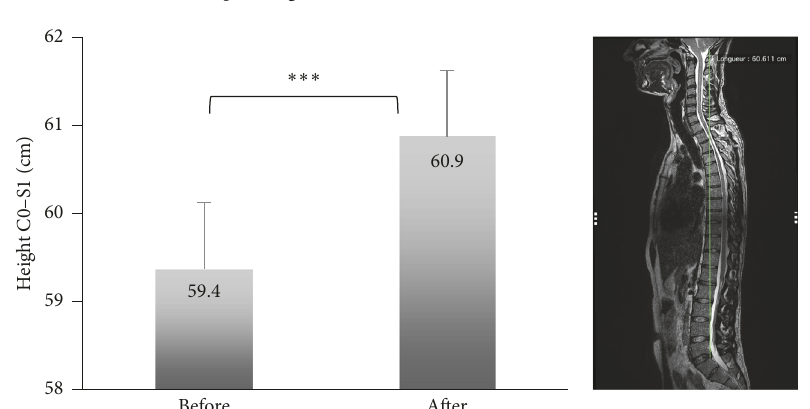
Figure 3: Comparison of spine height before and after dry immersion (DI) (Mean ± SD). Spine height between the foramen magnum (C0) and the superior and posterior endplate of the first sacral vertebra (S1). Comparison before and after DI ( 𝑃 < 0.001 ) (ANOVA repeated measures). ∗ ∗ ∗ means that 𝑃 < 0.001 .